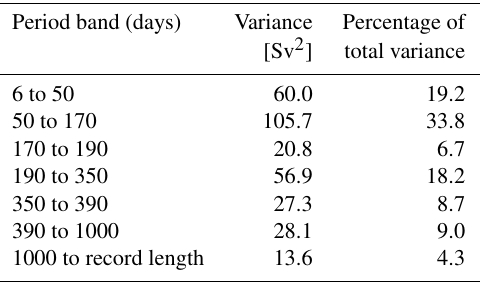
Figure 12. Time series of DWBC volume transport calculated from output of the OFES numerical model run described within the text. Transport was integrated within 800 to 4800dbar and between the longitudes of the real-world PIES at sites A and D. Top panel: the complete time series of absolute transport, with the every-3-day full resolution, is shown as the black solid line, while the relative and reference contributions calculated as in Fig. 6 are shown in blue dashed and red dash–dot lines, respectively. Bottom panel: annual cycle of the model DWBC transport anomaly, calculated and shown in the same manner as for the observational record shown in Fig. 7. Table 6. Distribution of variance in the indicated period bands in the DWBC transport calculated from the OFES model output. The model DWBC transport was integrated between 800 and 4800dbar and between the longitudes of the real locations for the PIESs at sites A and